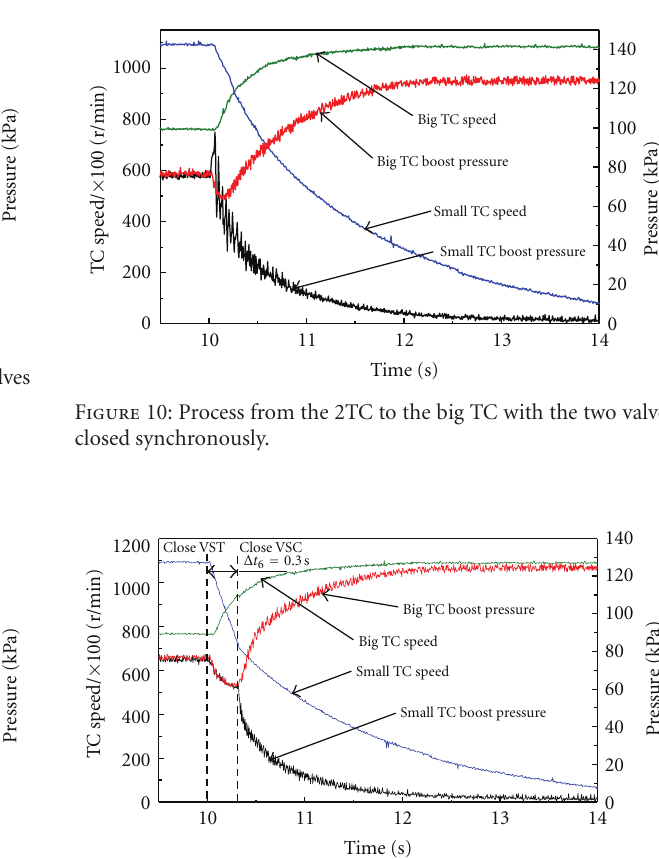
Figure 9: Process from the big TC to the 2TC with Δ t 5 = 0 . 3s.